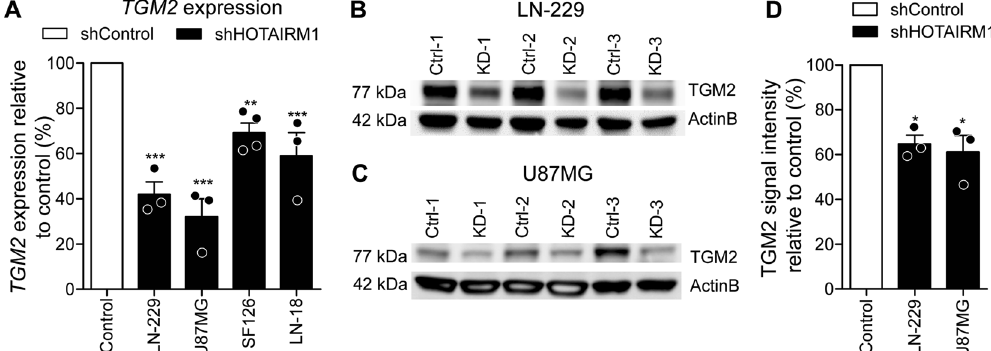
Fig. 5 TGM2 expression is correlated with HOTAIRM1 expression. A qRT-PCR for TGM2 expression was performed in control and stable HOTAIRM1 knock-down LN-229, U87MG, SF126, and LN-18 cell lines. White bar indicates the results of the respective control cells set to 100%. Note that HOTAIRM1 knock-down signi fi cantly reduces TGM2 mRNA levels. B – D Western blotting analysis of TGM2 protein expression in control versus stable HOTAIRM1 knock-down LN-229 ( B ) and U87MG ( C ) cell lines. Shown are three independent experiments. Beta-actin (ActinB) was used as a loading control. D Quanti fi cation of TGM2 protein expression by western blotting analysis in control versus stable HOTAIRM1 knock-down LN-229 and U87MG cell lines. White bar indicates the results of the respective control cells set to 100%. Two-way ANOVA was used for statistical calculation for qRT-PCR and Student ’ s t test was used for statistical analysis. Control: non-target shRNA; KD: shRNA-mediated HOTAIRM1 knock-down; mean ± SEM, *** p < 0.001, ** p < 0.01, * p < 0.05. n = 3. Cell Death and Disease (2021)